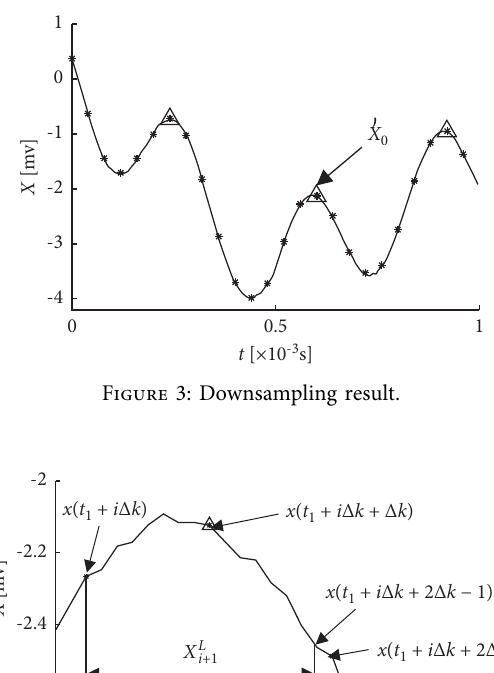
Figure 4: Local resampling